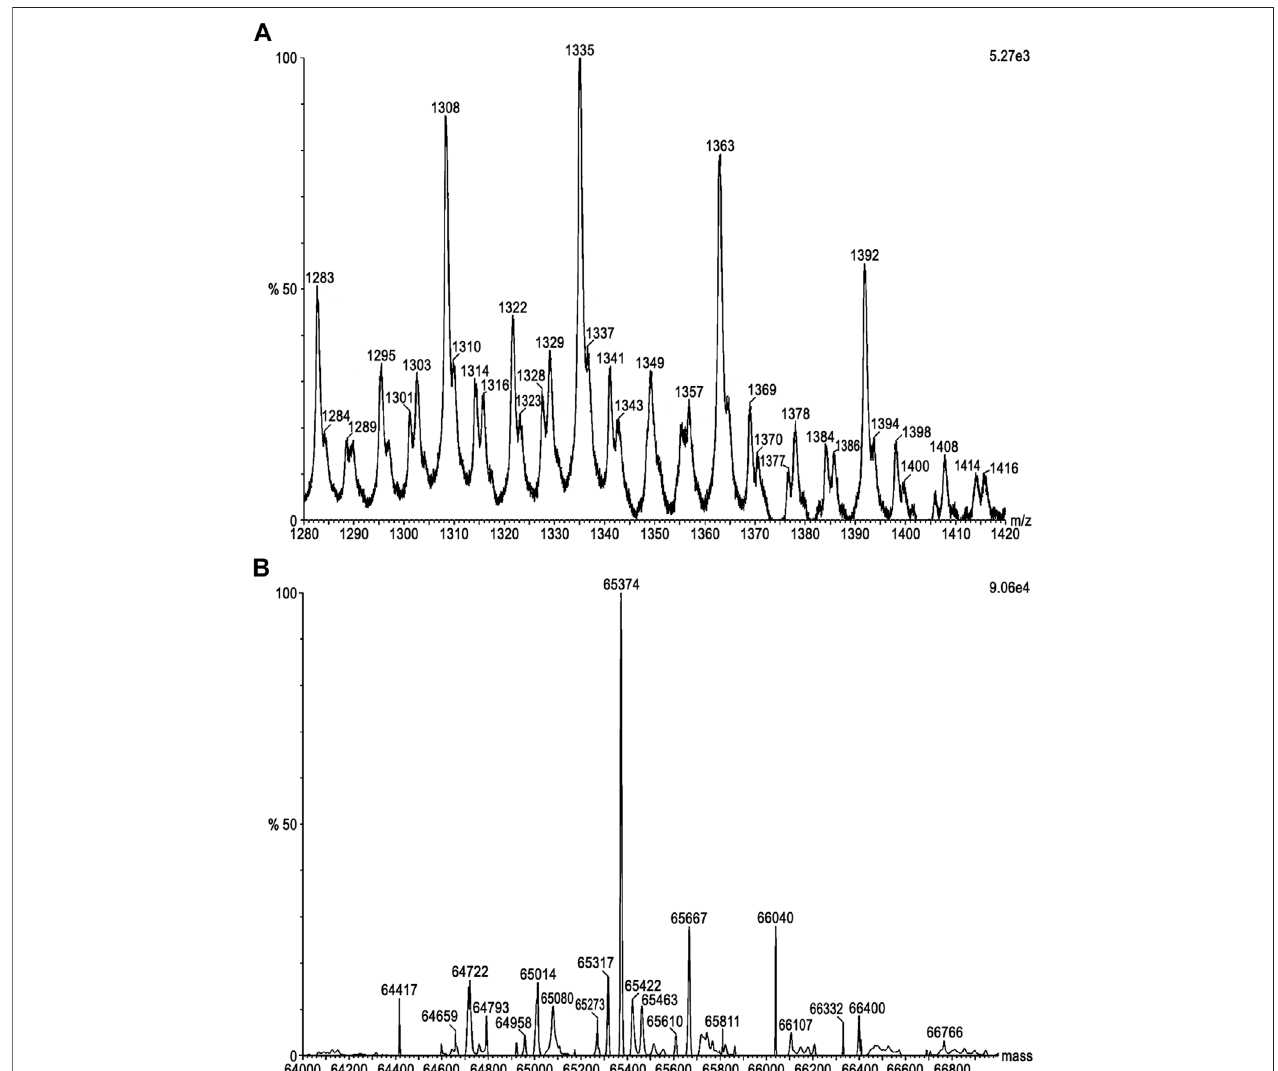
FIGURE1 | Molecular massdetermination ofDM64 by ESI-MS. The setup was composed ofan Agilent 1200 HPLC system coupled toa Waters SynaptG1 mass spectrometer. DM64 (50 pmol) was desalted on a Waters MassPREP microdesalting column (2.1 × 5.0 mm; 20 μ m; 1,000 Å) followed by direct elution into the ion source for MS analysis. Acquired data were submitted to analysis with the MassLynx software, including (A) background subtraction, choice of m/z range for further processing, and (B) deconvolution using MaxEnt 1 algorithm to generate the fi nal mass values.